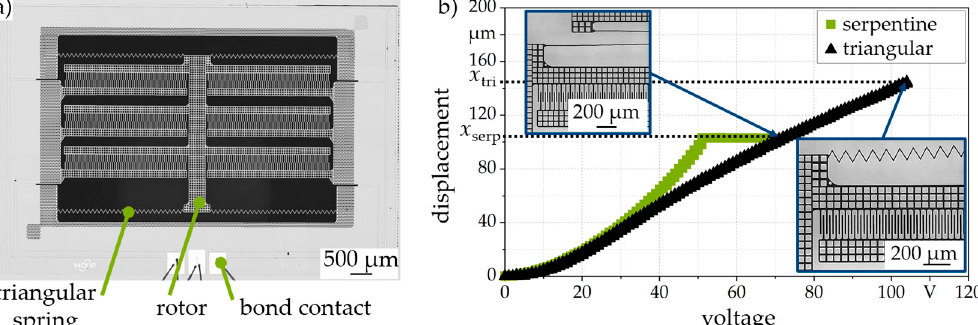
Figure 6. ( a ) Microscopic image of a characterized comb-drive actuator with a triangular spring, ( b ) characterization result comparing the displacement of comb-drive actuators.